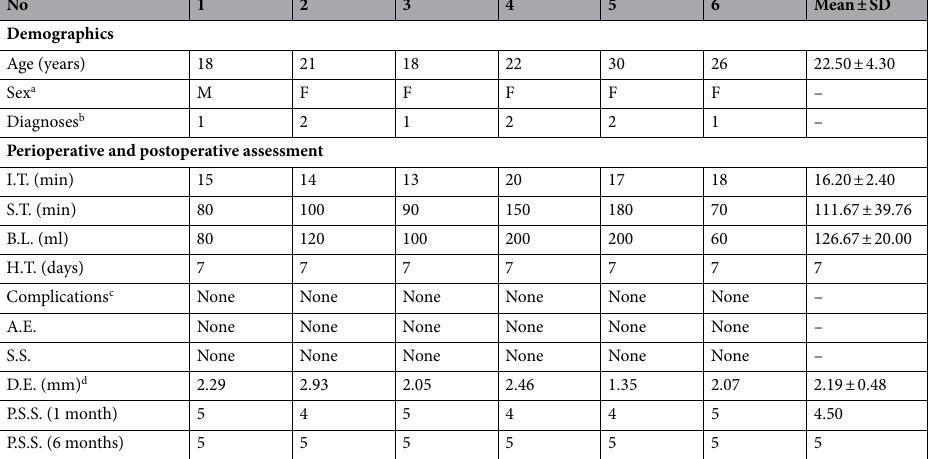
Table 1. Demographics, perioperative and postoperative assessment for patients. I.T. Installation time, S.T. Surgical time, B.L. Blood loss, H.T. Hospital time, A.E. Adverse events, S.S. Second surgery, D.E. Distance